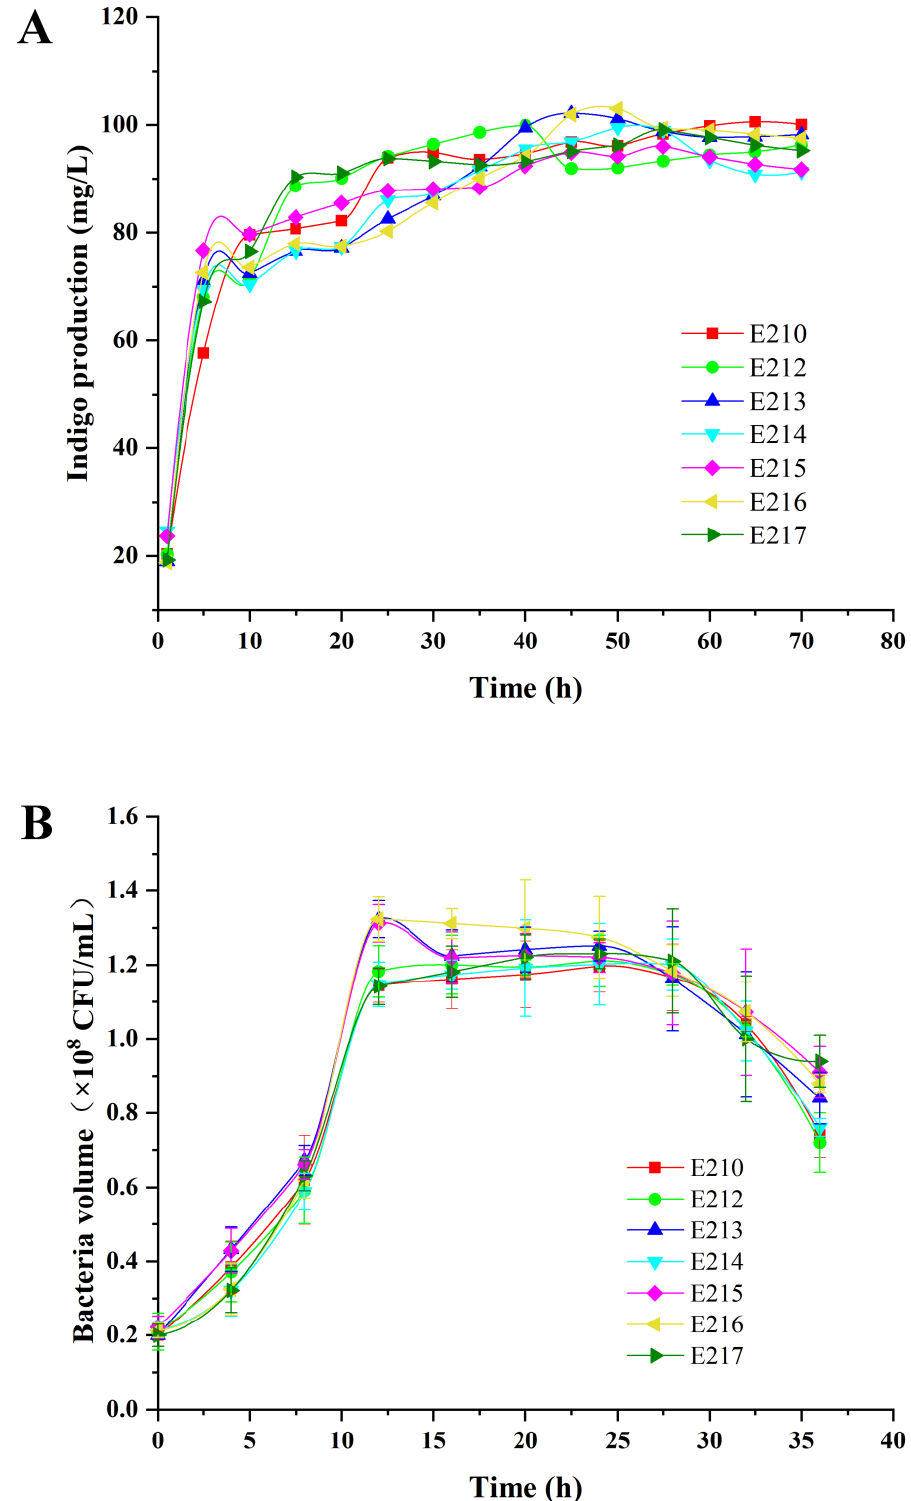
Figure 2. The growth curves of recombinant strains E210, E212, E213, E214, E215, E216 and E217 after different times of culture in LB medium ( A ) and fermentation medium ( B ).